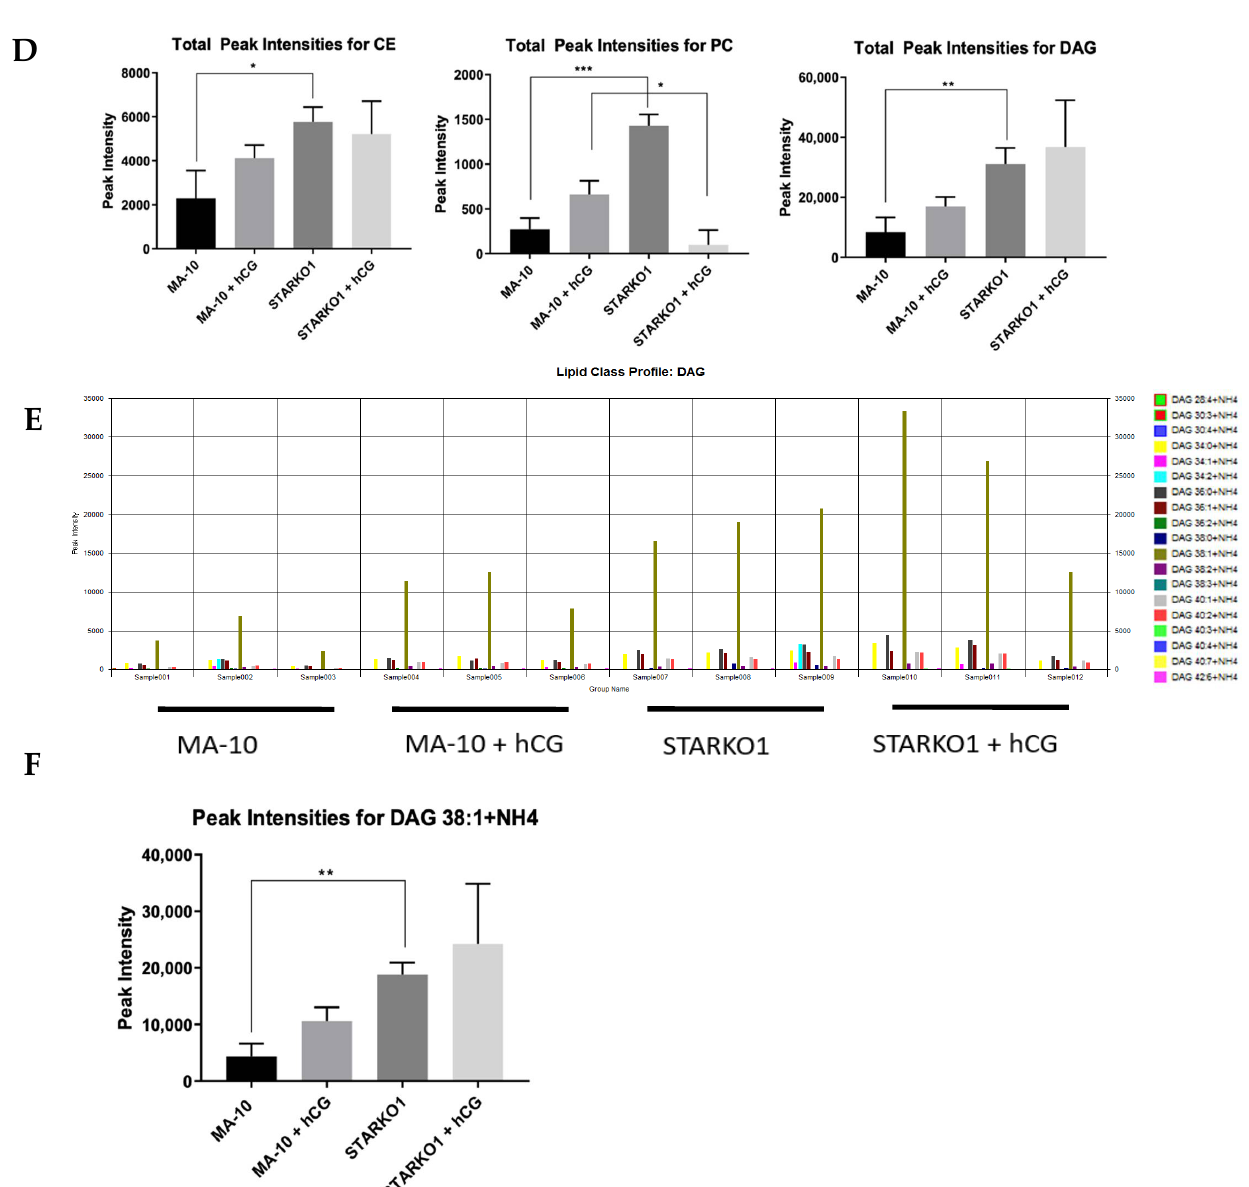
Figure 5. Alterations in lipid droplet content between WT MA-10 and STARKO1 cells. ( A ) Bodipy 493/503 staining of lipid droplets in MA-10 (left) and STARKO1 (right) cells with quantification shown to the right. Scale bar: 10 μm. ( B ) Electron microscopy images of lipid droplets in WT MA-10 cells (left) and STARKO1 cells (right). Arrows point to lipid droplets. ( C ) Peak intensities of various lipid classes identified in lipid droplets of wild-type MA-10 and STARKO1 cells in the absence and presence of hormonal stimulation. ( D ) Peak intensities of lipid classes shown to be significantly altered between lipid droplets of wild-type MA-10 and STARKO1 cells in the absence and presence of hormonal stimulation. ( E ) Peak intensities of individual diacylglycerol (DAG) species identified in lipid droplets of MA-10 and STARKO1 cells. ( F ) Peak intensities of DAG 38:1 in lipid droplets of MA-10 and STARKO1 cells in the absence and presence of hormonal stimulation. Data are shown as the mean ± SEM. * p < 0.05; ** p < 0.01; *** p < 0.001.